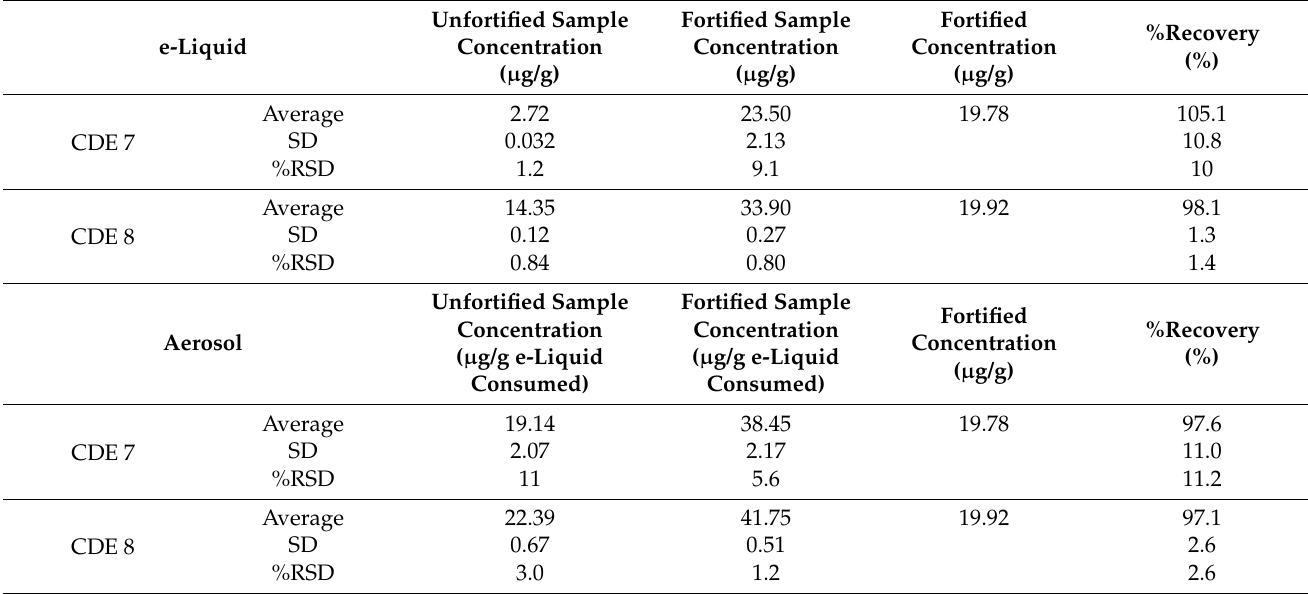
Figure 7. Comparison of average amounts (n = 4) of acetal adducts measured in fortified reference e-liquid (15% water, 2.5% NBW in a 50/50 mixture of PG and Gly) and aerosol emission (CD device). Table 3. Method accuracy (fortification experiments, n = 4): %recovery values of formaldehyde in e-liquid and aerosol emission (CDE7 and CDE8) of 50